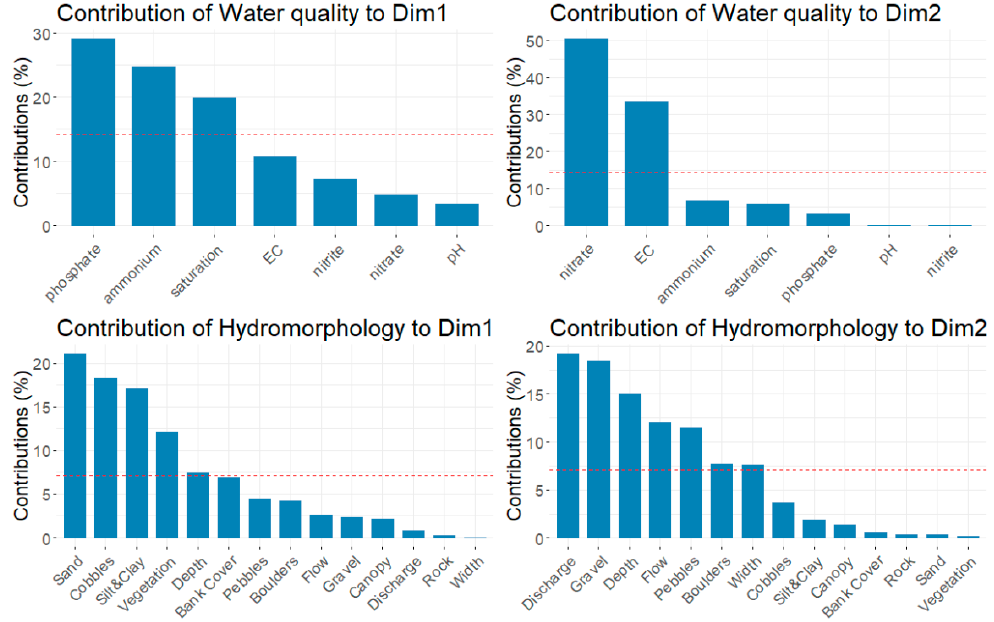
Figure 4. Bars show the % contribution of each variable to principal components 1 and 2 of the PCA for water quality variables (top two graphs) and the hydromorphological variables (bottom two graphs). The red dashed line in each graph indicates the expected average contribution.